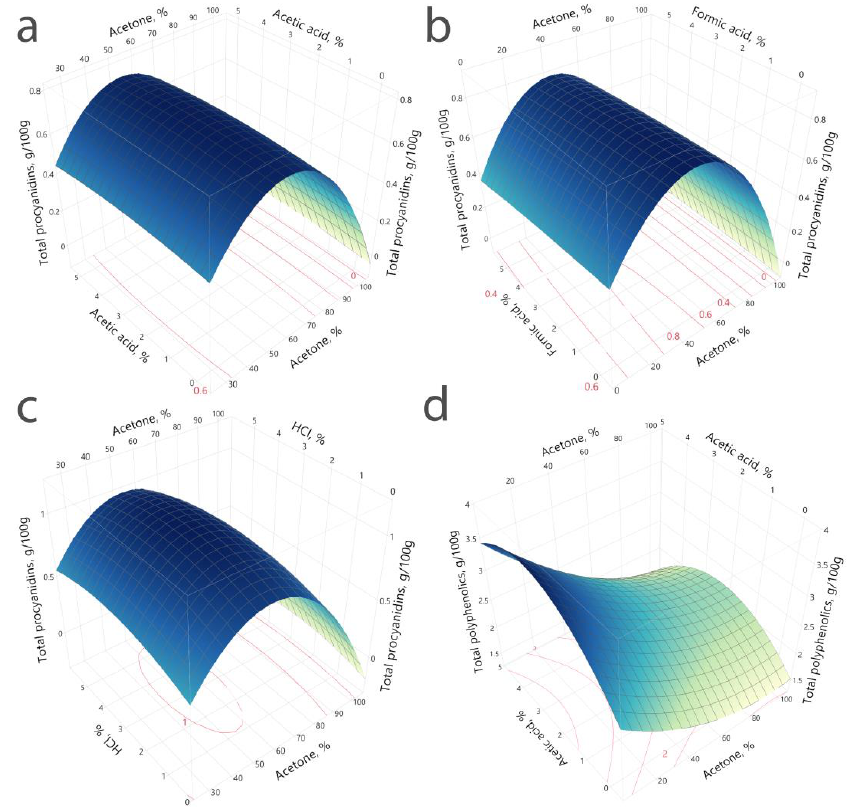
Figure 2. Response surface graphs showing the effect of acetone (X 1 ) and added acid (X 2 ) concentra- tion on the measured response (total procyanidins): ( a ) shows the effects of adding acetic acid; ( b ) formic acid; ( c ) hydrochloric acid; ( d ) shows the effects of adding acetic acid and acetone concentra- tion on the yield of total polyphenolics.